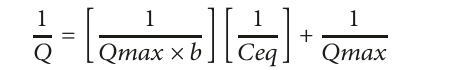
Figure 5: The ionic strength effect on myoglobin binding [m microbeads : 20 mg, pH: 7.0, t: 1h, T: 25 ∘